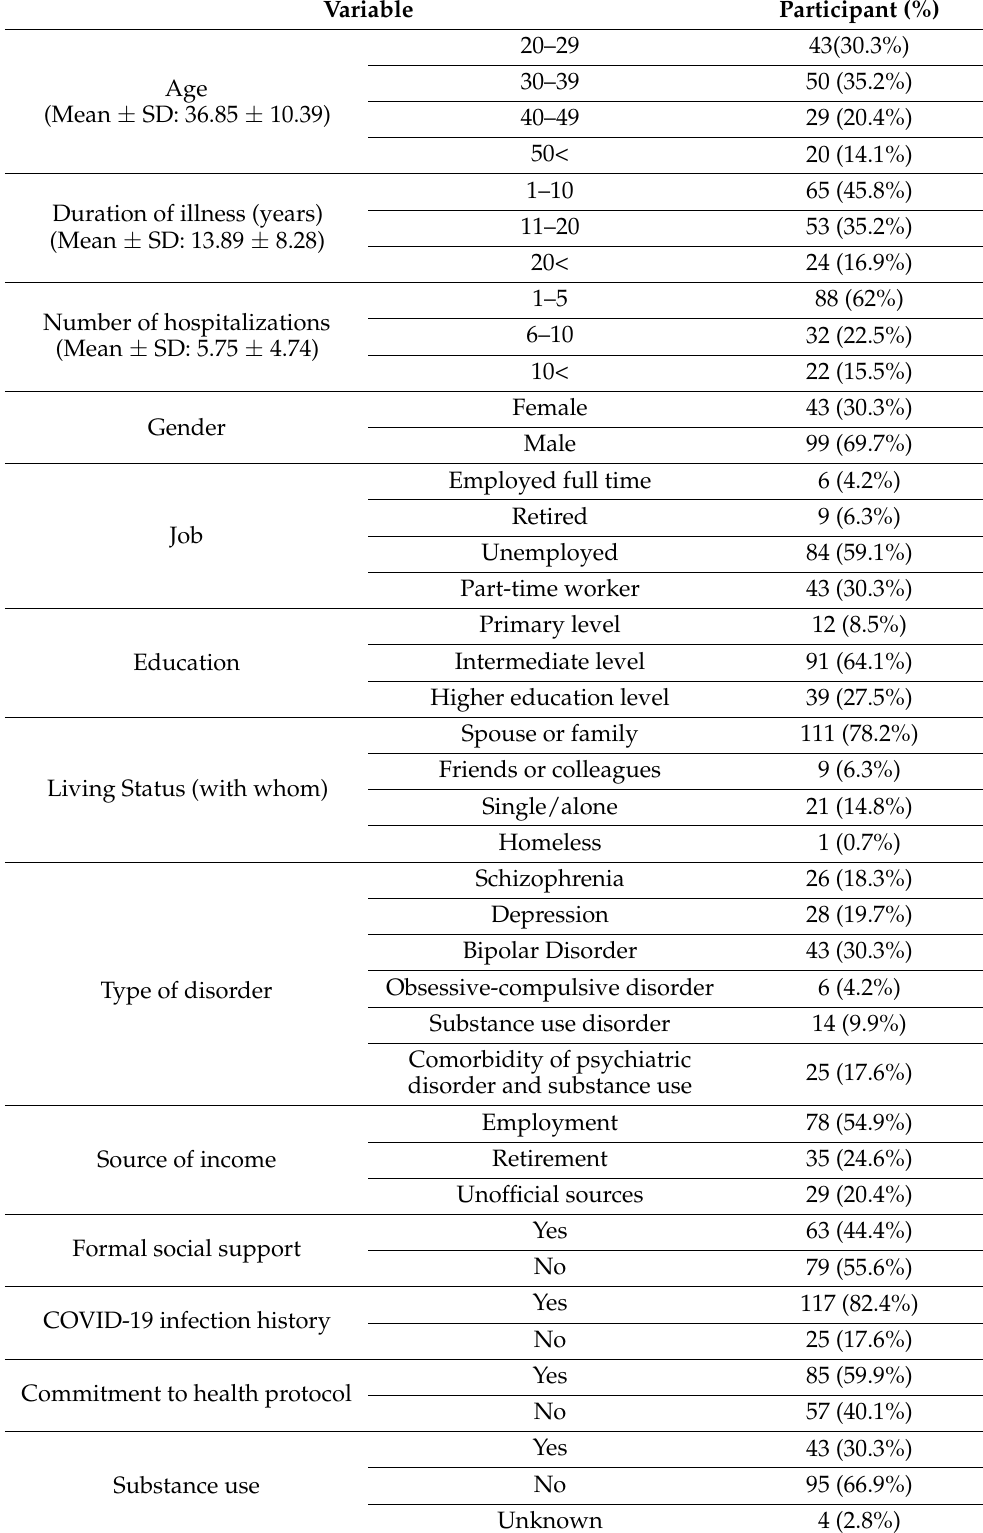
Table 1. Sociodemographic characteristics of the study